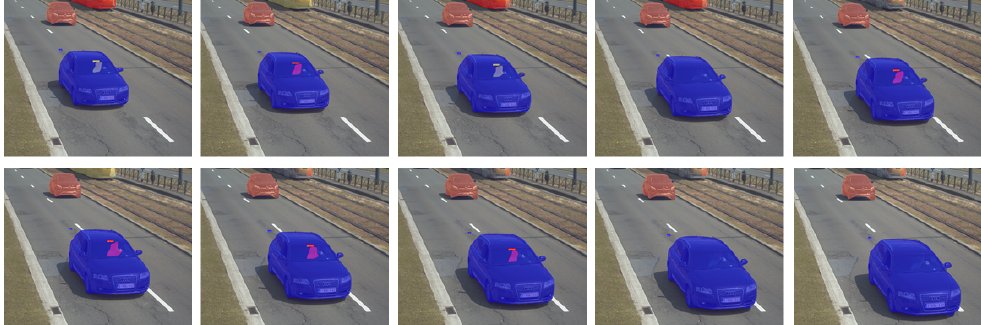
Figure 9. Qualitative instance segmentation results of SOLACT on a real traffic